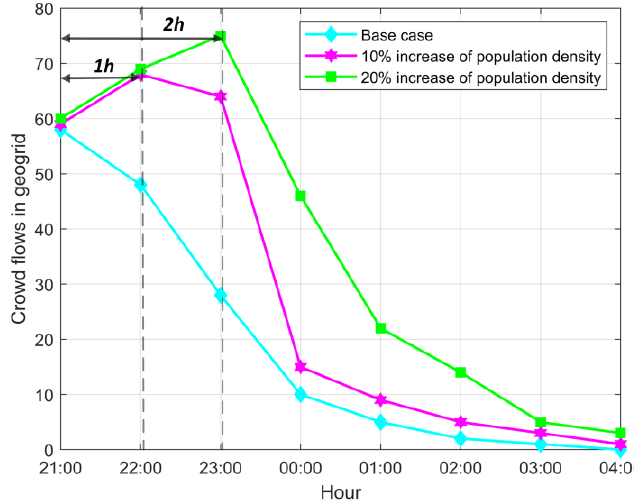
Figure 11. Correlation between night crowd flows and population density in Haikou. As the population density of the land use area increases, the regional crowd flows will lag accordingly. For every 5% increase in population density, the peak of crowd flows will be delayed by 30 min.